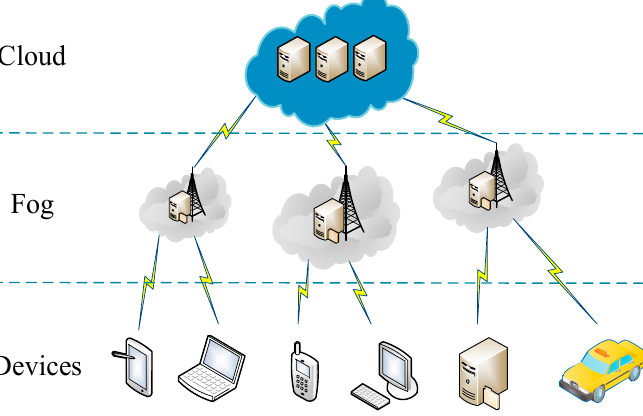
Figure 1. System model in fog-cloud computing environment.